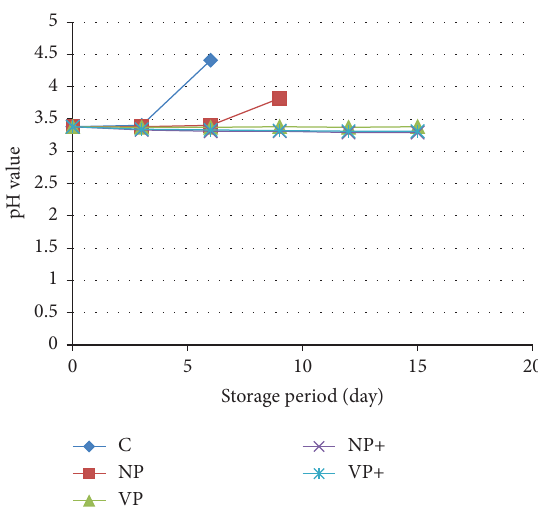
Figure 4: pH value of injera samples through diferent storage intervals. For “C” and “NP” treatments, the experiment was ter- minated at 6 th and 9 th day of storage, respectively, since the samples were